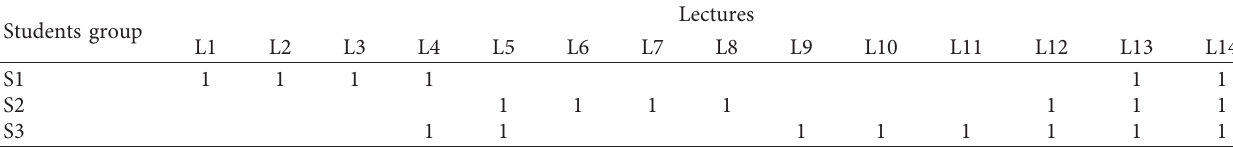
Table 13: Suitable lectures for each group of students.